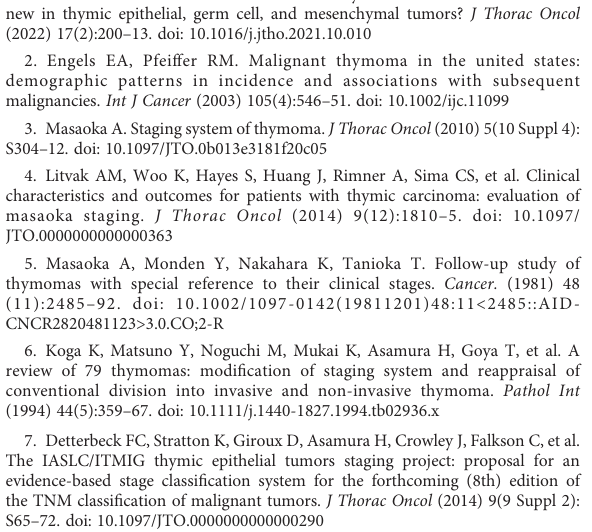
SUPPLEMENTARY FIGURE 1 Decision curve analysis of the nomogram for predicting the net bene fi t rates of patients with TETs. (A – C) The net bene fi t rates of 12- (A) , 36- (B) , and 60-month (C) in the in-house cohort. TETs, thymic epithelial tumors; OS, overall